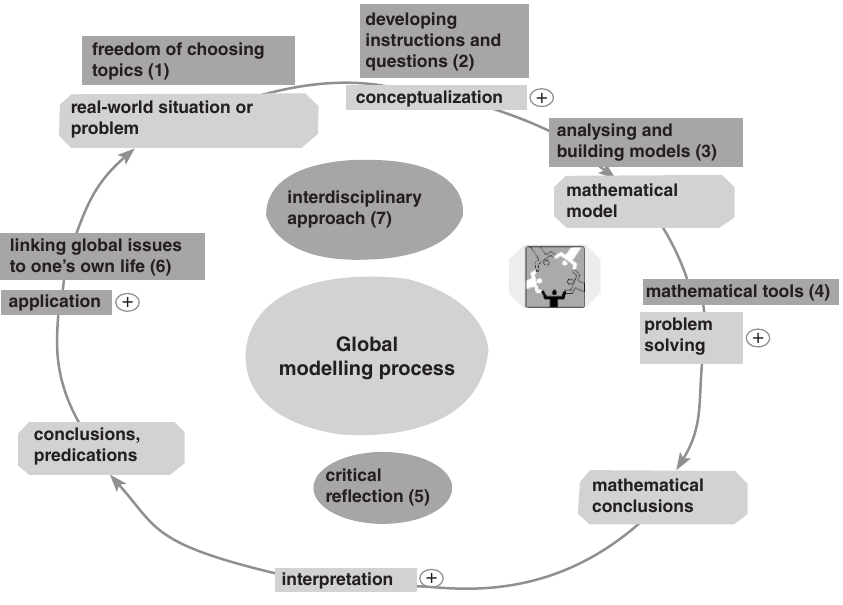
Figure 5: Critical issues related to the modelling process (derived from Figure